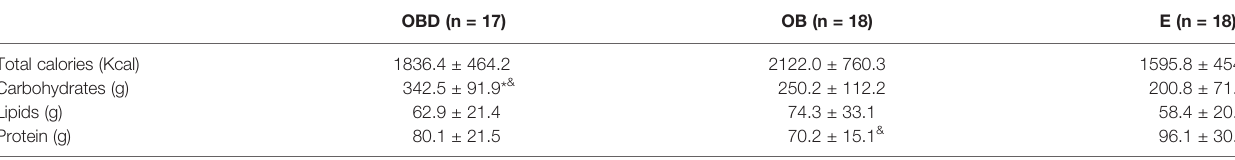
TABLE 2 | Carbohydrates, protein, lipids and total calories ingestion of obese diabetic (OBD) or Obese without associated disease (OB) or Eutrophic (E) middle-aged